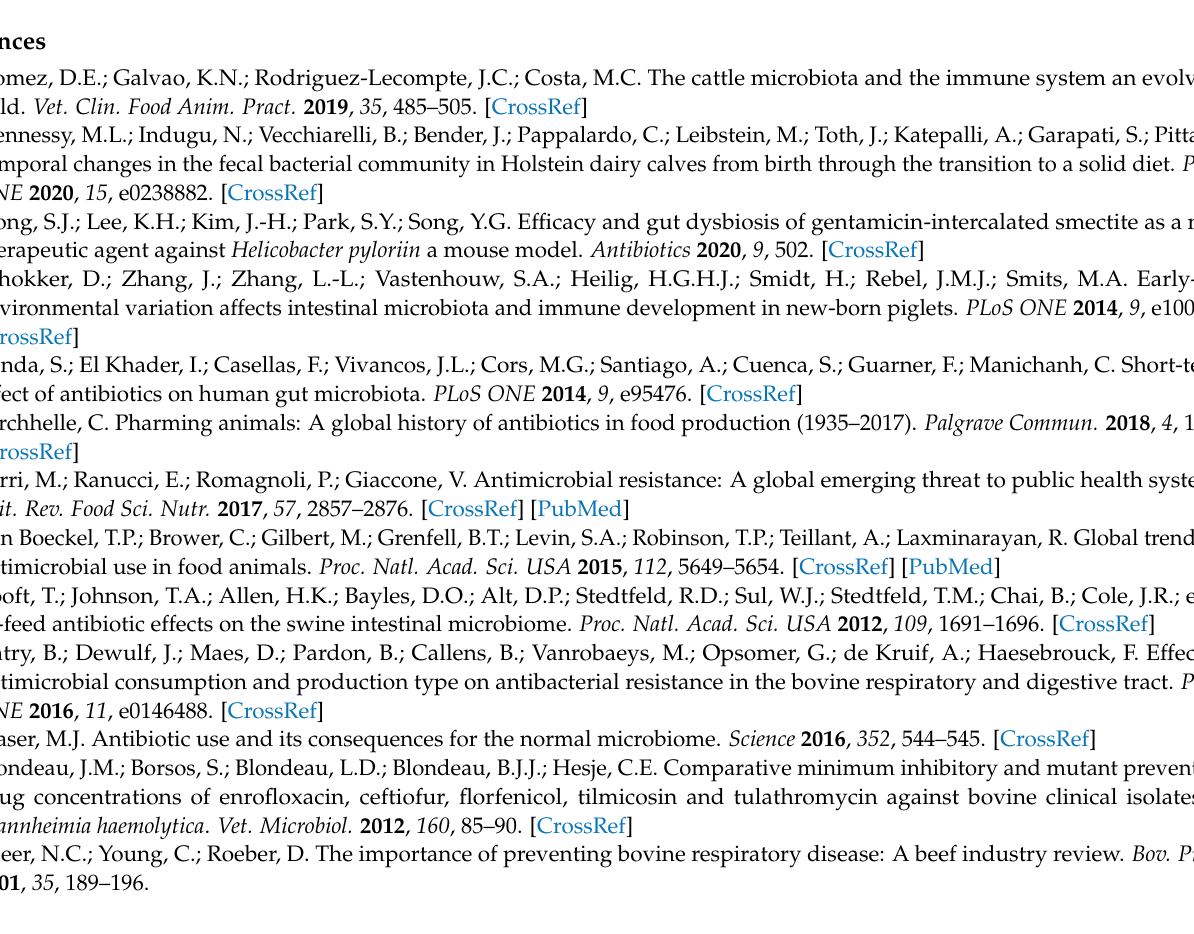
Table S2: Analysis of composition of microbiomes (ANCOM) comparing pre-and post-treatment samples at the genus level, Table S3: Reservoirs of antimicrobial resistance genes detected in pooled samples—control group, Table S4: Reservoirs of antimicrobial resistance genes detected in pooled samples—low-dose healthy group, Table S5: Reservoirs of antimicrobial resistance genes detected in pooled samples—high-dose healthy group, Table S6: Reservoirs of antimicrobial resistance genes detected in pooled samples—high-dose sick